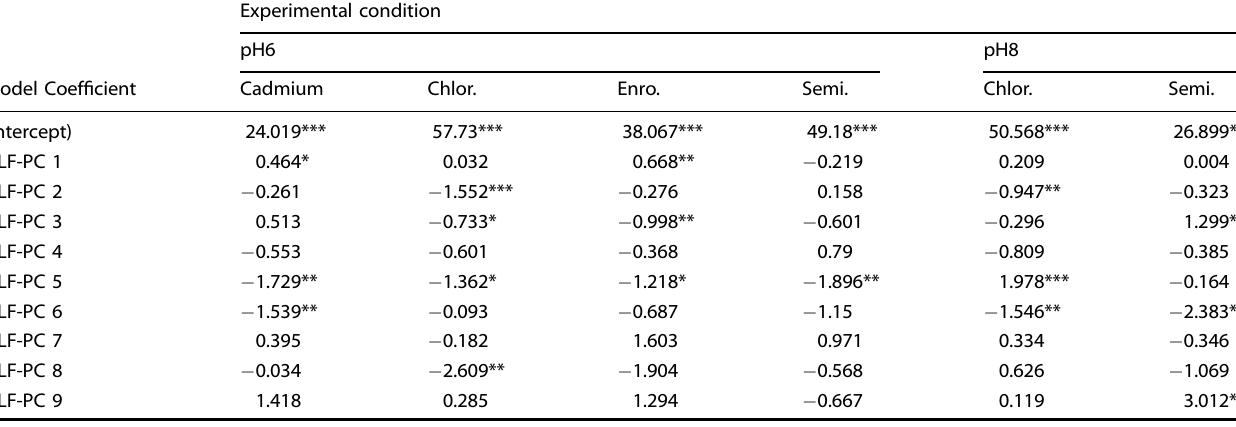
Table 2. Signi fi cant features for each experimental condition.